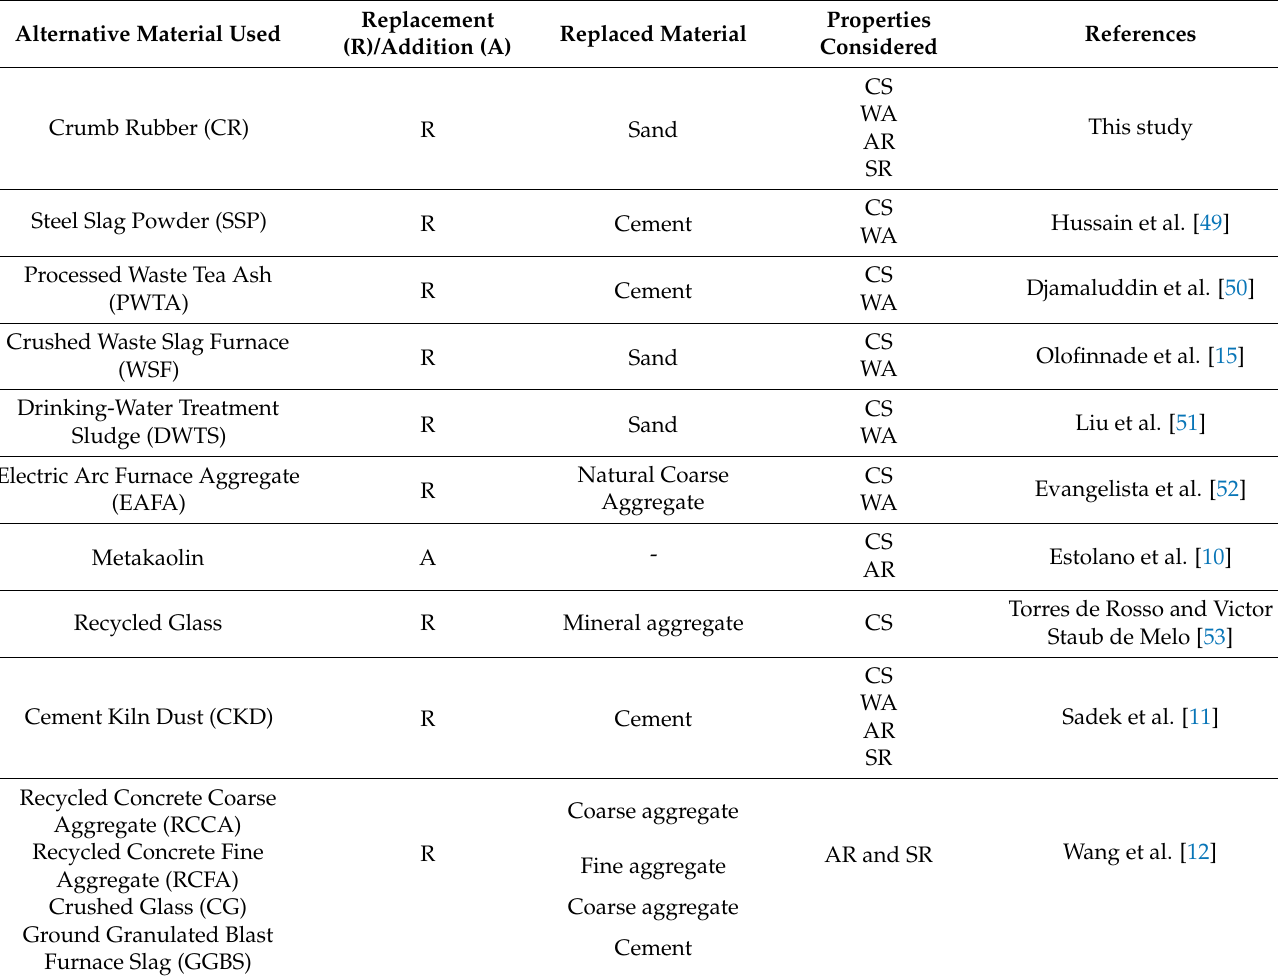
Table 7. Studies considered for the property